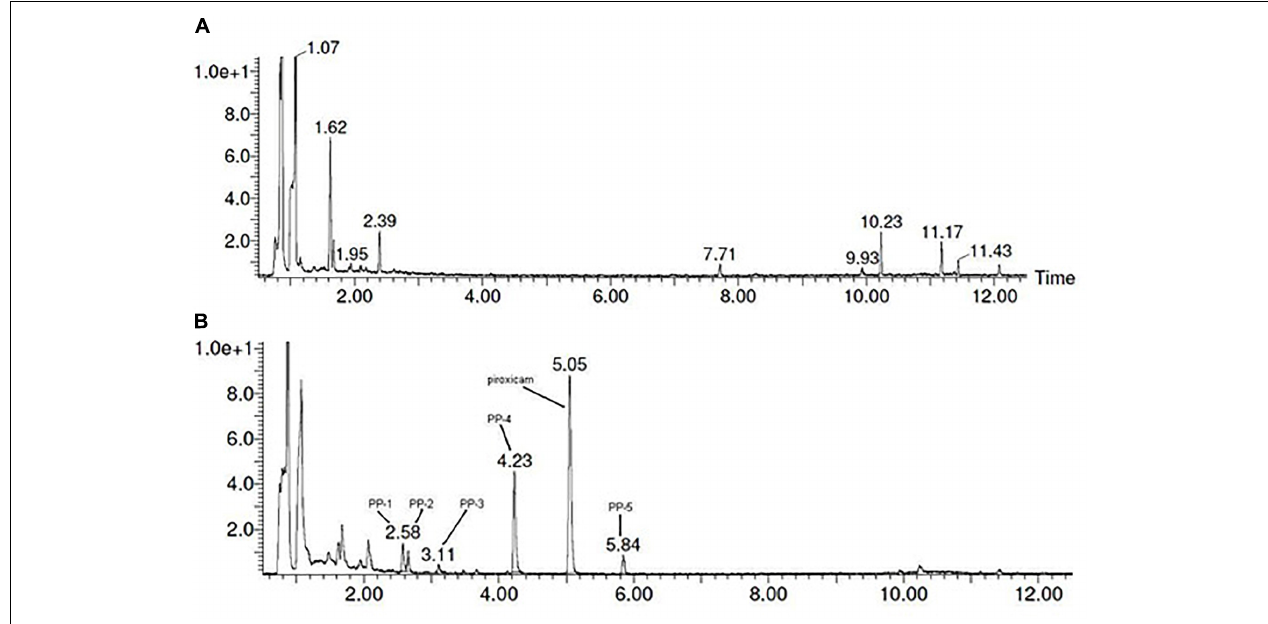
FIGURE 1 | UPLC-DAD chromatograms obtained for: (A) Oddoux medium from in vitro culture of L. edodes ; (B) Oddoux medium from in vitro culture of L. edodes with addition of piroxicam (20 mg/250 mL) in the beginning of logarithmic phase of mycelium growth.